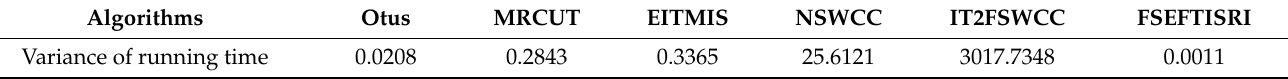
Table 5. Variance of running time of several